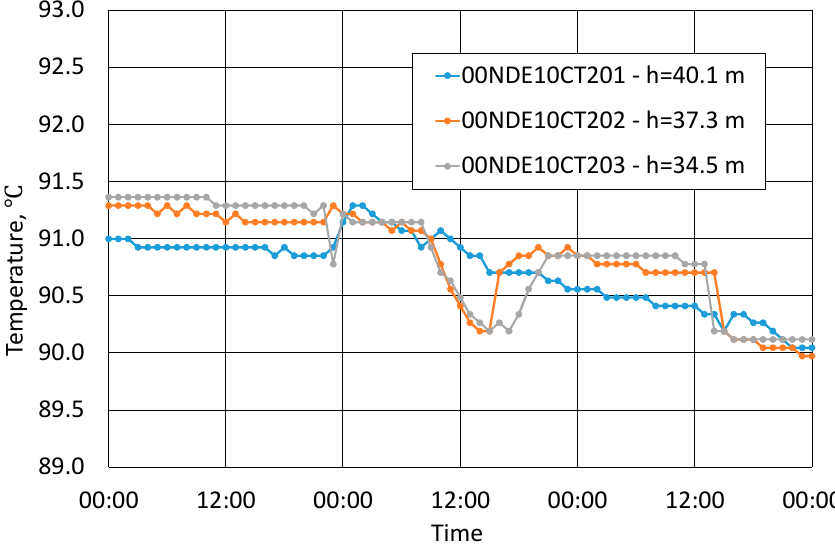
Figure 8. Measured temperatures of stored hot water in the upper part of the TES tank during three selected 24-h periods (transition period, charging, storing and discharging processes) for CHP Siekierki in Warsaw.